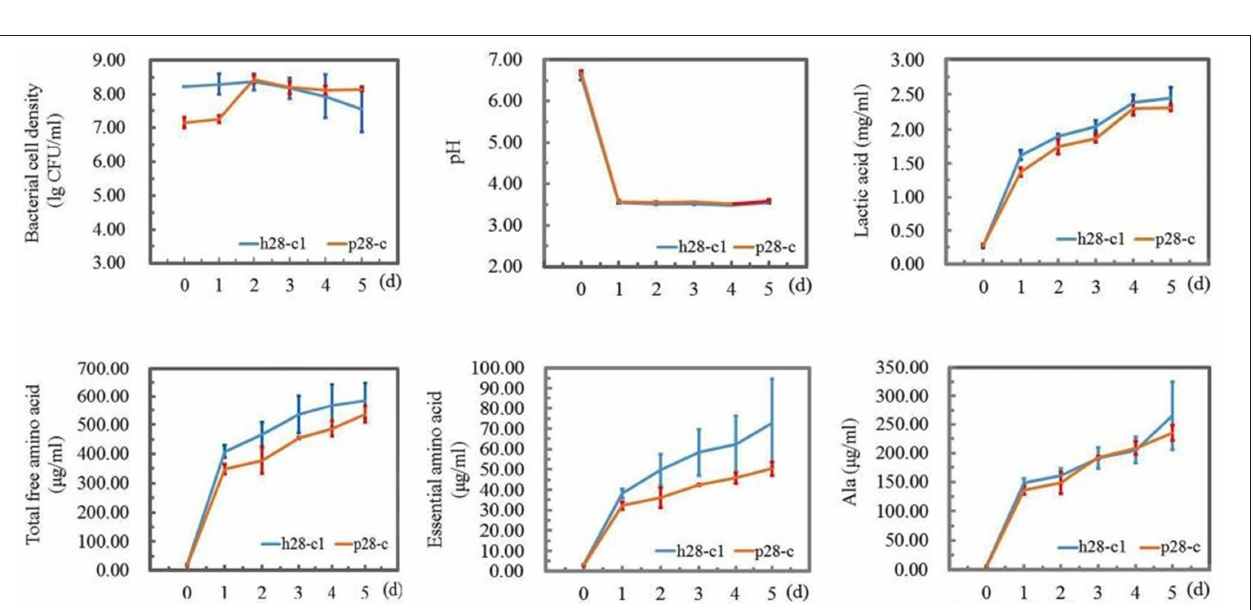
FIGURE 9 | Preparation of Suanzhou with in-lab fermentations. Strain L. casei h28-c1 and L. pentosus p28-c were used as starters. Bacterial cell density (lg cfu/ml), pH, lactic acid, total free amino acid, essential amino acid, and alanine content were evaluated, respectively.